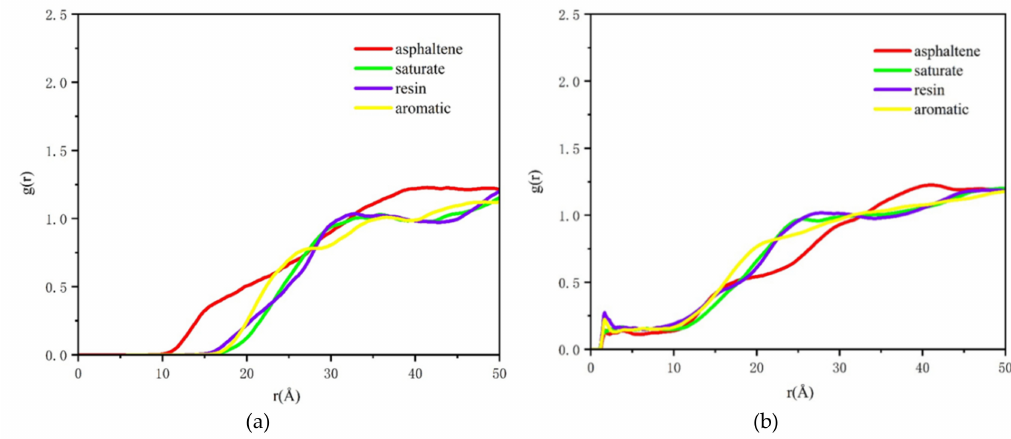
Figure 2. RDF curves of four asphalt components under wet condition. ( a ) Asphalt-water-calcite, ( b )